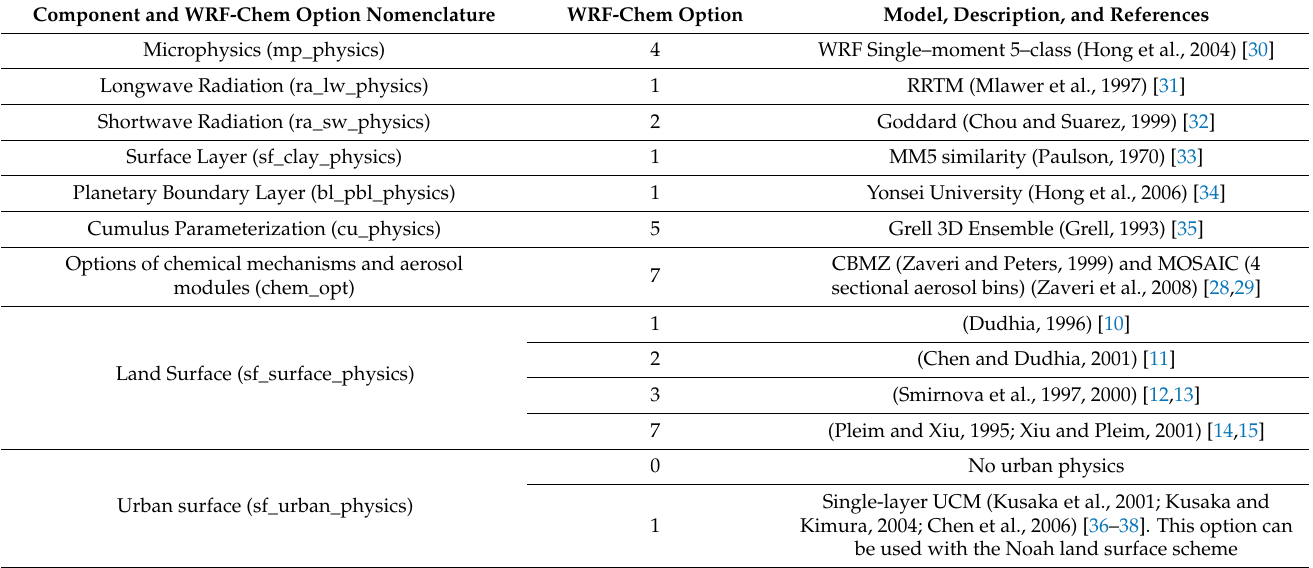
Table 3. Main schemes and options selected for modeling the meteorology and air quality in Cuenca (WRF-Chem